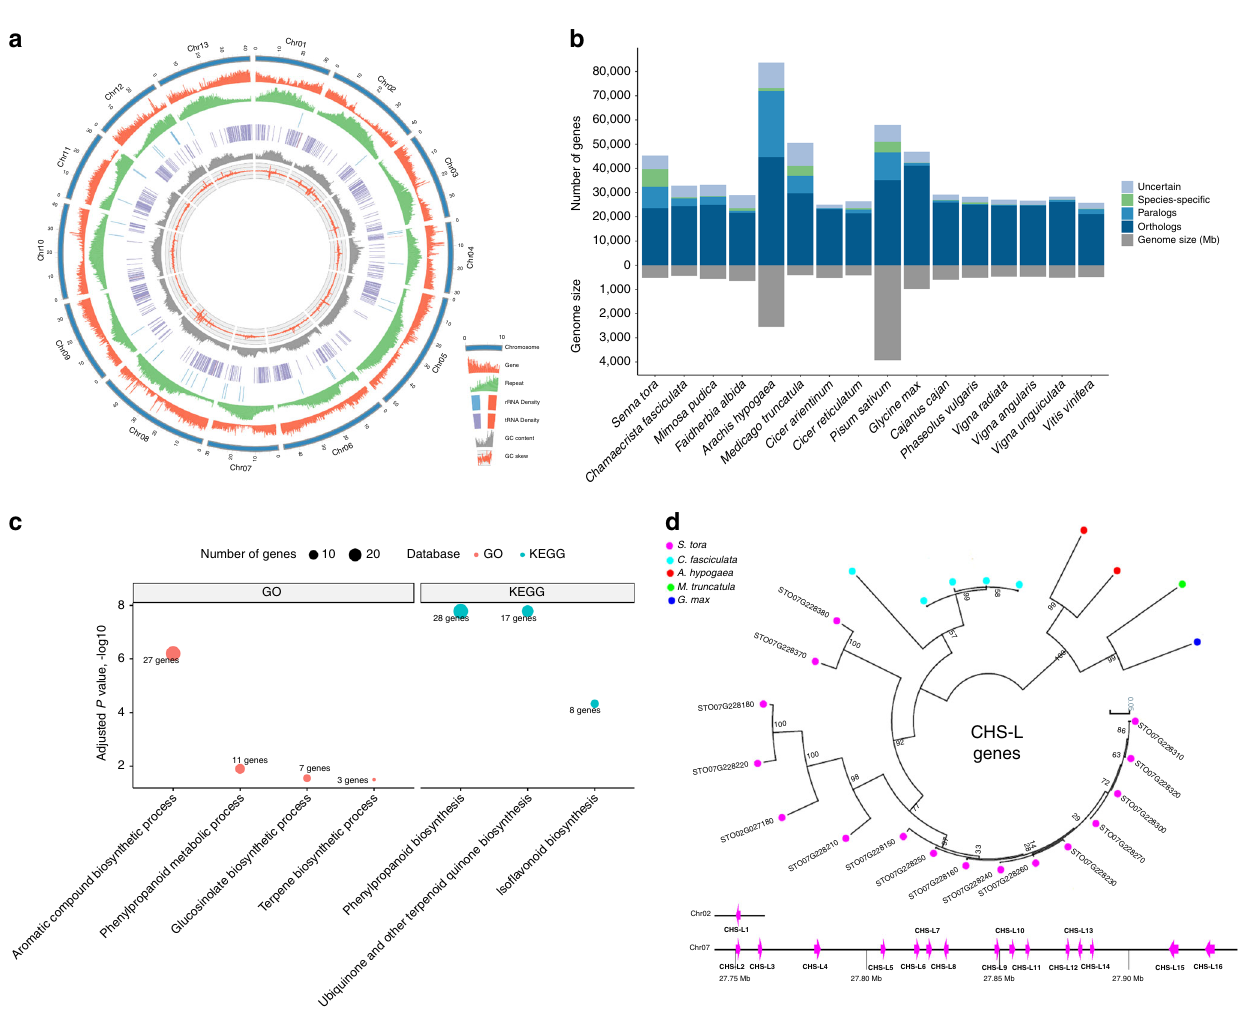
Fig. 1 The S . tora genome and comparative genomic analysis. a The landscape of genome assembly (~502 Mb) and annotation of S. tora . Tracks (from outside) correspond to chromosomes (Chr01 – Chr13 on a Mb scale), gene density, repeat density, rRNA density, tRNA density, GC content, and GC skew. Tracks are drawn in nonoverlapping 100-kb sliding windows. The red bars in the rRNA and tRNA tracks represent the maximum density of copies on the scale. b An overview of orthologous and paralogous genes among S. tora , related legumes, and V. vinifera . “ Uncertain ” indicates homologous genes obtained from BLAST but not found using OrthoMCL. “ Species-speci fi c ” genes do not have any similarity to genes in the other species based on BLAST and OrthoMCL. c Signi fi cantly enriched biological process GO and KEGG categories (specialized metabolism) of expanded gene families in S. tora . d Lineage- speci fi c expansion of the CHS-L gene family in S. tora and four other legumes. The 15 tandemly duplicated gene clusters are ordered and shown on chromosome 7, as well as one gene on